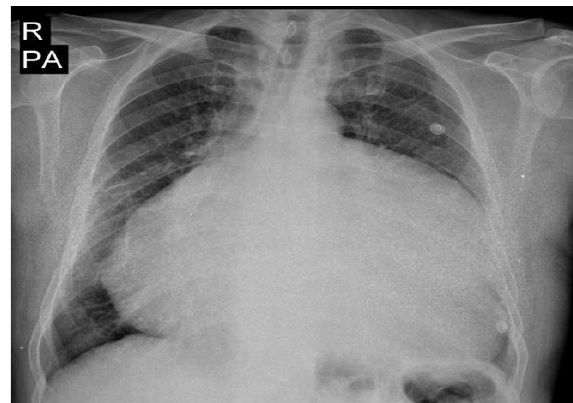
Figure 1. Chest X-ray before surgery.